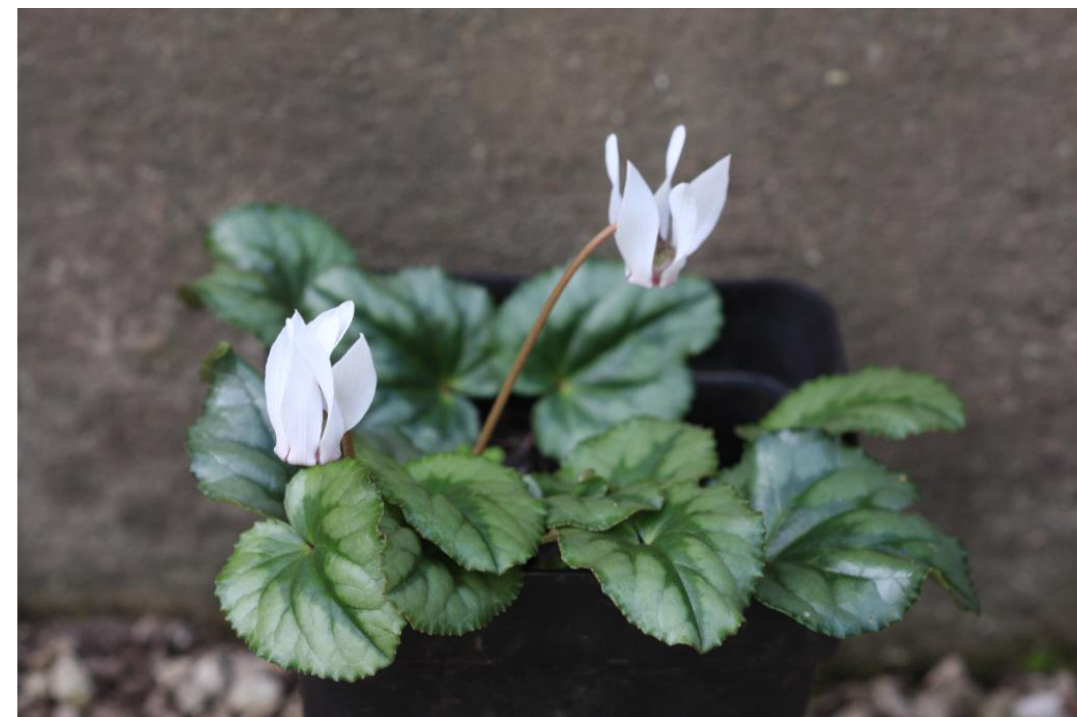
Figure 12. C. purpurascens ‘Bela Ljubljana’.